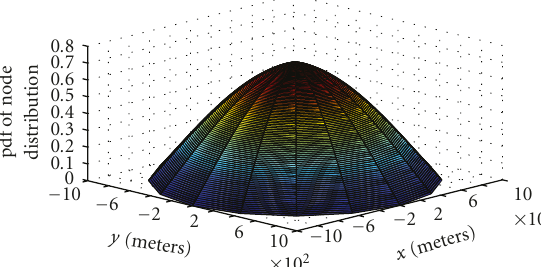
Figure 3: Random Waypoint spatial distribution in Cellular